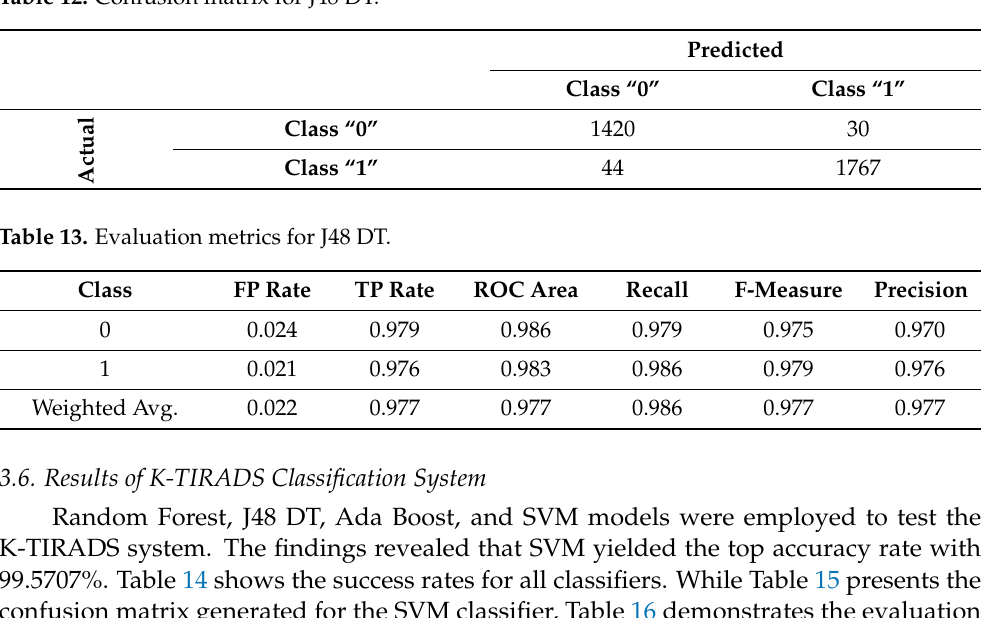
Table 12. Confusion matrix for J48 DT.